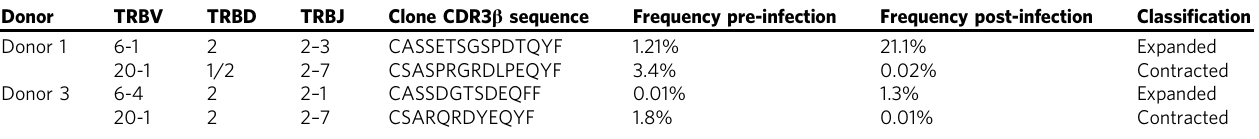
Table 1 TCR β clonotypes used for Jurkat.MAIT